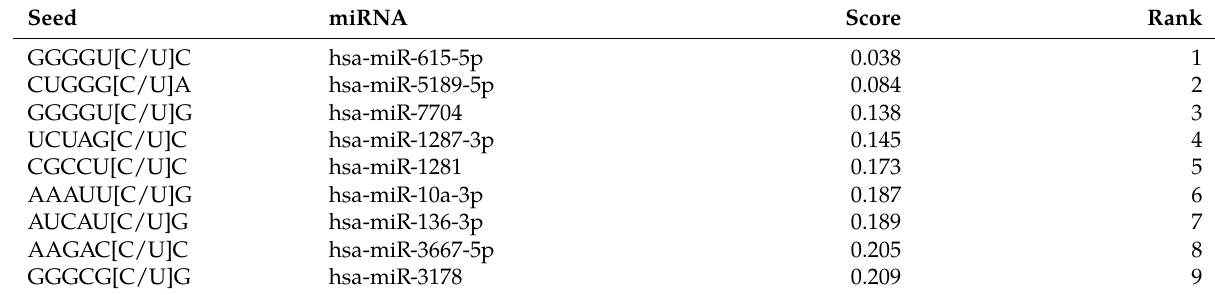
Table 1: Top ranked microRNA seed mutations.